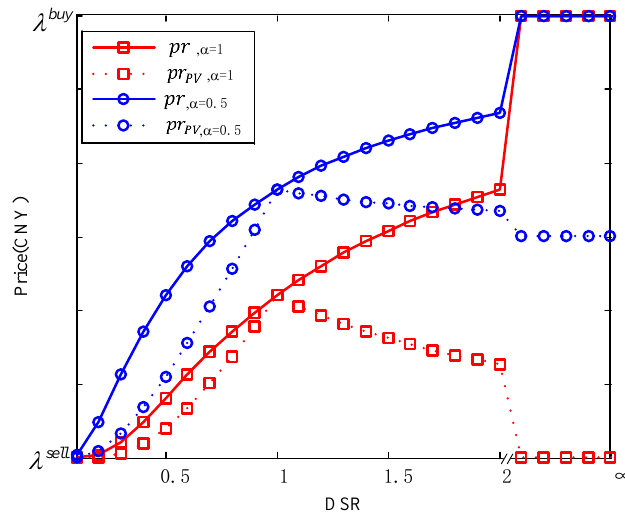
Figure 3. The relationship between internal buying price and PV selling price with DSR.